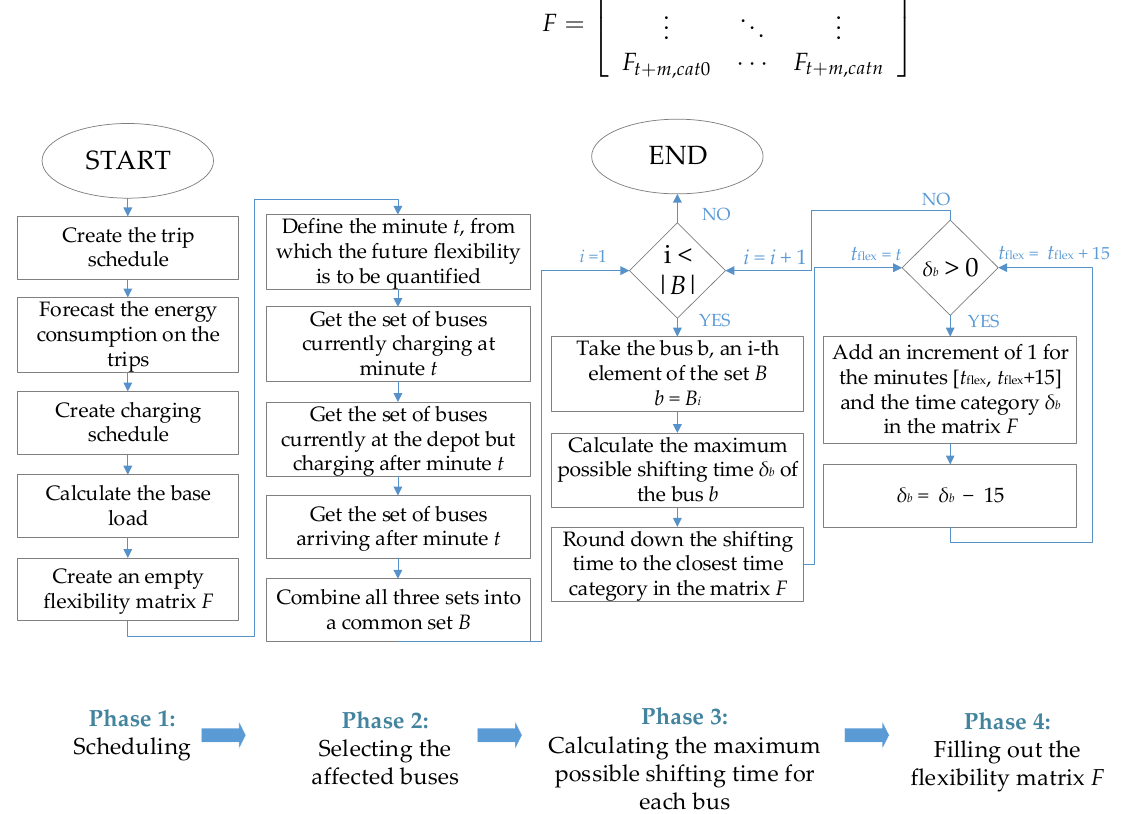
Figure 7. Process of flexibility quantification divided into four phases, as used in this paper.